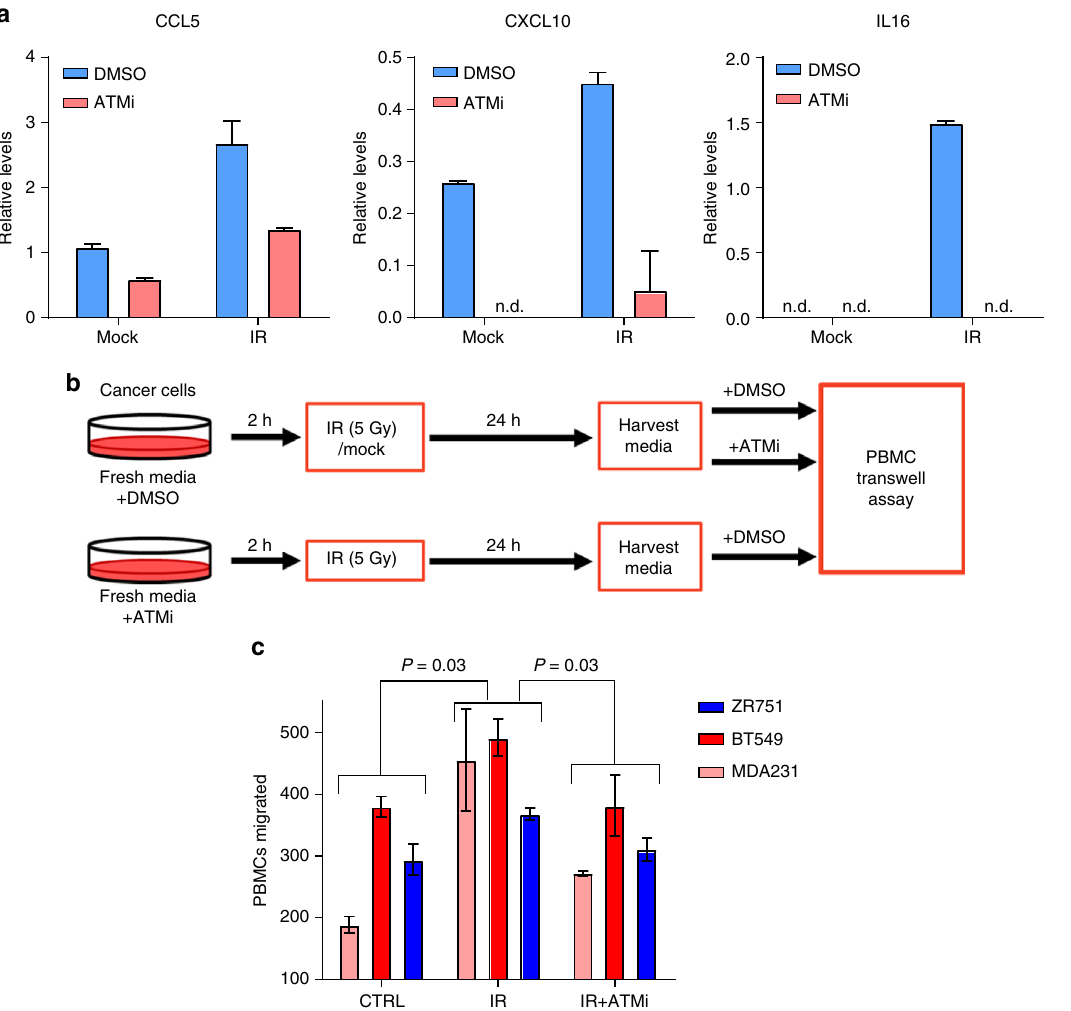
Fig. 6 Phosphorylation of ATM induces cytokine secretion and PBMC migration. a Quanti fi cation of CCL5, CXCL10, and IL16 secretion by ELISA following irradiation of BT549 breast cancer cells either in presence or absence of ATM inhibitor KU-55933 at 10 μ M. Values plotted as mean ± std of duplicate spots. See Supplementary Fig. 7. b Schematic for collection of conditioned media for PBMC transwells. Final concentration of ATM inhibitor KU-55933 was equal in all conditions (10 μ M). c Migration of PBMCs towards tumor cell conditioned media from triple negative breast cancer cell lines MDA-MB-231 and BT-549 and luminal breast cancer cell lines ZR-75-1. Error bars represent ± standard deviation of duplicate runs. Signi fi cance determined by ANOVA using a Holm-Sidak post-hoc